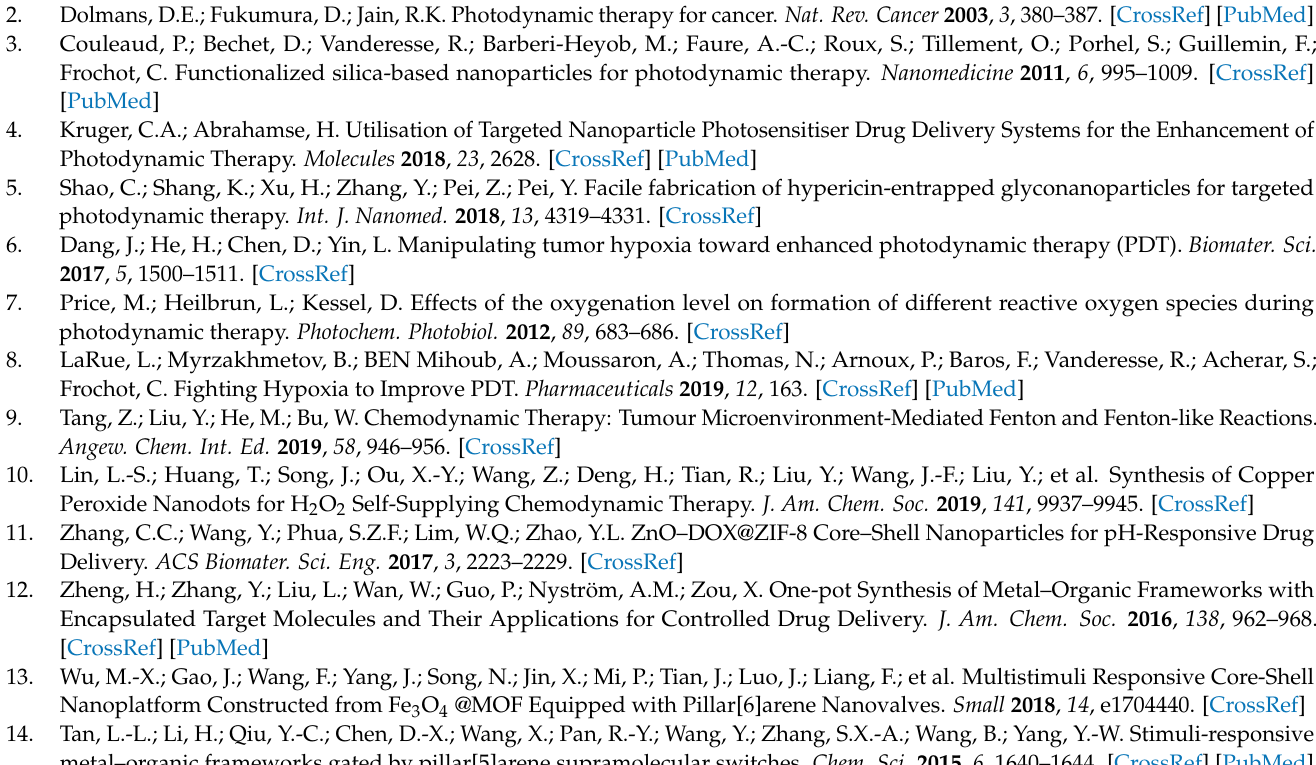
different materials, Figure S5: Zata potential studies of OCZWM, Figure S6: SEM images of